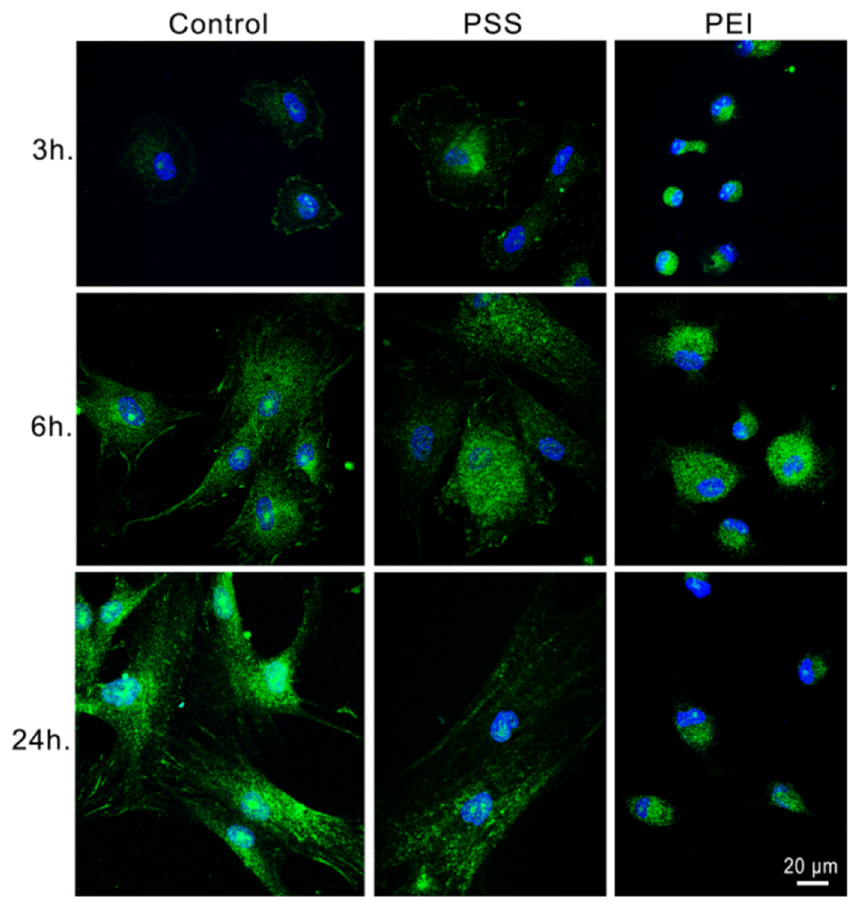
Figure 5. Representative images of MSCs after 3 h, 6 h, and 24 h of culture time on glass slides, PSS-ended slides, and PEI-ended slides. Green represents FITC-conjugated antibody stain of FAK, blue represents DAPI stain of nuclei. Scale bar: 20 μ m (for all the images shown).